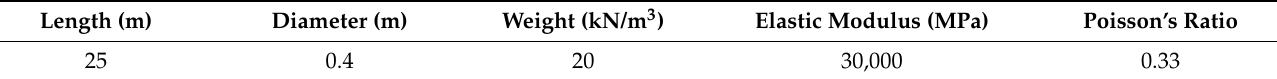
Table 3. The parameters of pile.